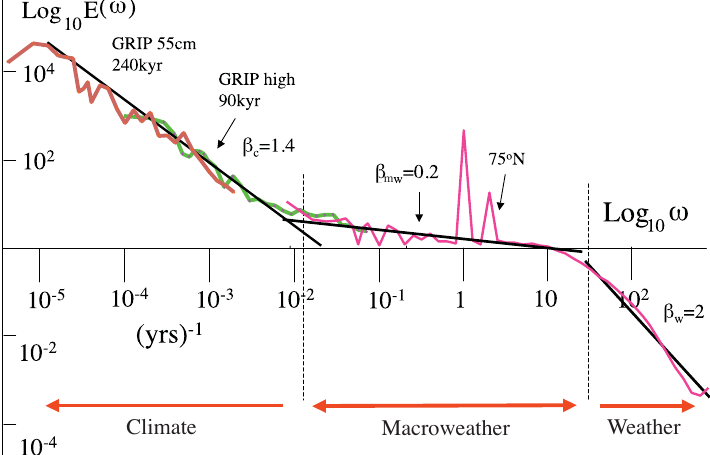
Fig. 2. A composite temperature spectrum: the GRIP (Summit) ice core δ 18 O, a temperature proxy, low resolution (left, brown) along with the first 91kyr at high resolution (left, green), with the spectrum of the (mean) 75 ◦ N 20th century reanalysis (20CR, Compo et al., 2011) temperature spectrum, at 6h resolution, from 1871 to 2008, at 700mb (right). The overlap (from 10–138yr scales) is used for calibrating the former (moving them vertically on the log–log plot). All spectra are averaged over logarithmically spaced bins, ten per order of magnitude in frequency. Three regimes are shown corresponding to the weather regime with β w =2 (the diurnal variation and harmonic at 12h are visible at the extreme right). The central low frequency weather “plateau” is shown along with the theoretically predicted β mw =0.2–0.4 regime. Finally, at longer timescales (left), a new scaling climate regime with exponent β c ≈ 1.4 continues to about 100kyr. Note that a recent revised chronology may modify the very lowest frequencies. Reproduced from Lovejoy and Schertzer (2012b). The black lines are reference lines with the (absolute) slopes indicated.